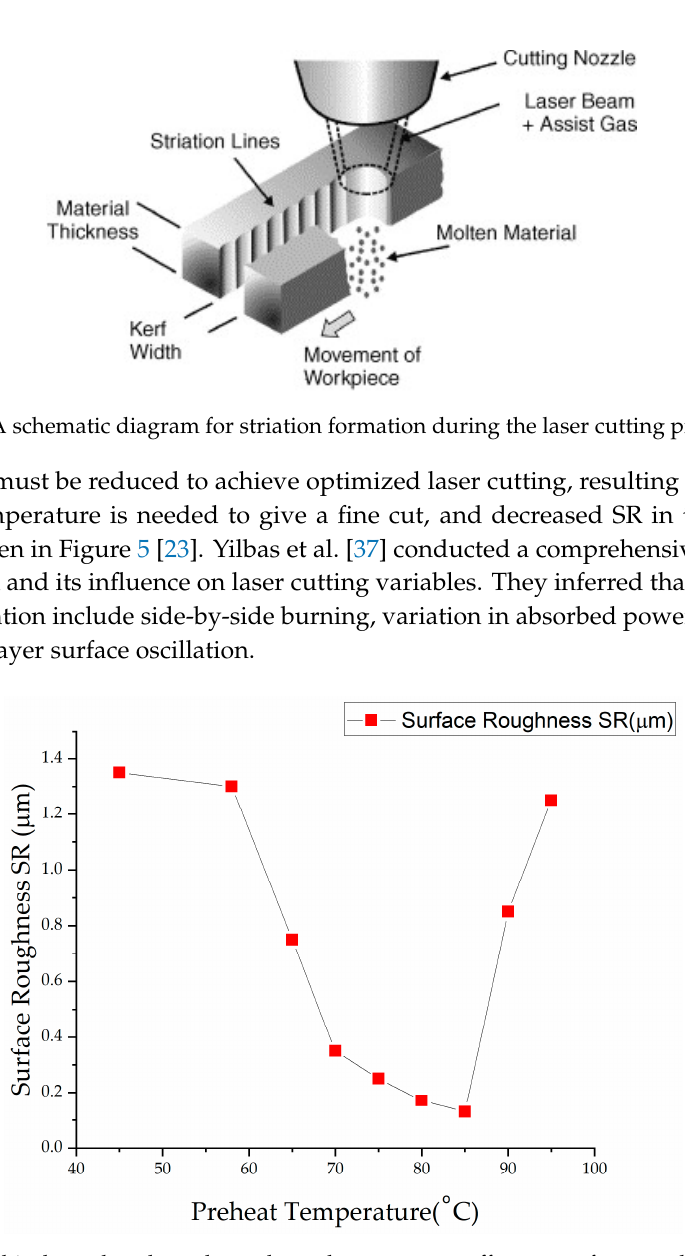
Figure 5. Graphical trend to show the preheated temperature effect on surface roughness (SR) [23].